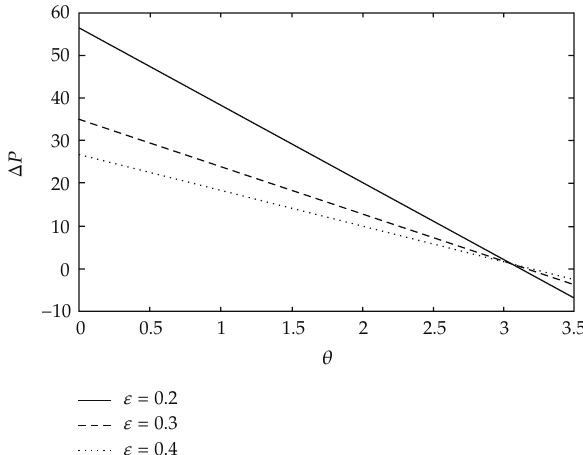
Figure 3: The pressure rise verses flow rate when α (cid:9) 0 . 01 , a (cid:9) 0 . 2 , b (cid:9) 0 . 6 , d (cid:9) 0 . 8 , λ 1 (cid:9) 0 . 4 , Da (cid:9) 0 . 5, and φ (cid:9) π/ 4.